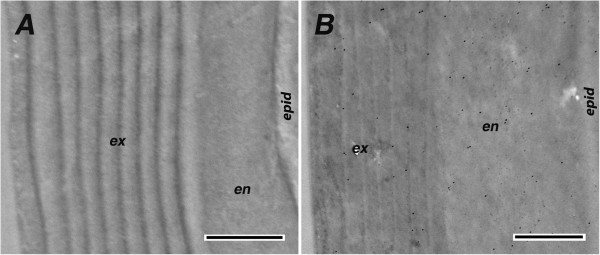
Sections of 1-d-old mosquito legs treated with the pre-immune serum. Preimmune serum was collected from the same animals used to raise the anti-CPF3 (A) and the anti-CPLCG3/4 (B). Secondary antibodies were anti-mouse and anti-rabbit, respectively. ex, exocuticle; en, endocuticle; epid, epidermis. Scale bar=500 nm.